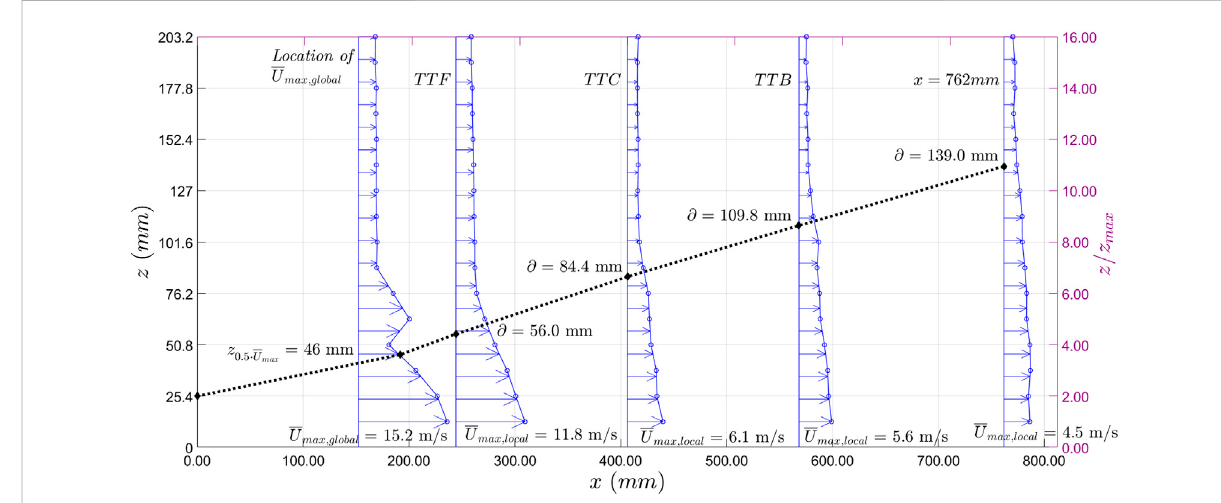
FIGURE 10 Downburst wall jet growth at the time of global peak velocity at various downstream distances for Option